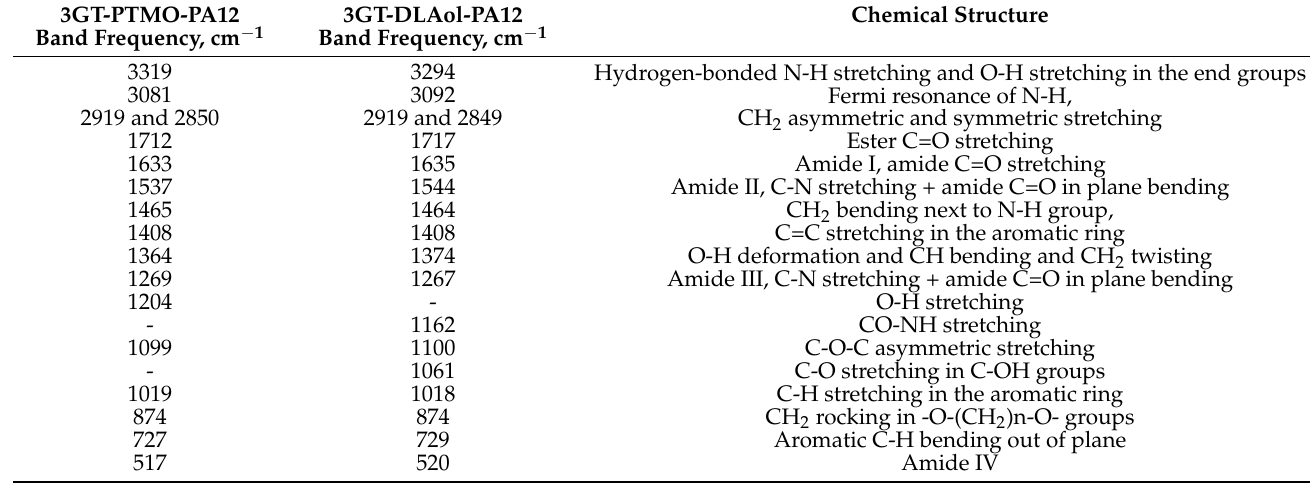
Table 2. Wavenumbers and assignments of Fourier transform infrared (FT-IR) spectra band exhibited by obtained terpolymers. 3GT-PTMO-PA12 Band Frequency, cm −